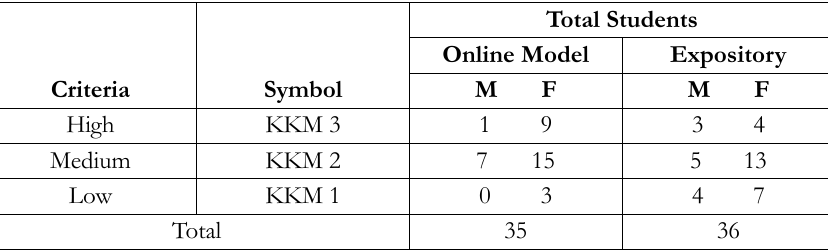
Table 5. Total of Distribution of Students Based on Gender